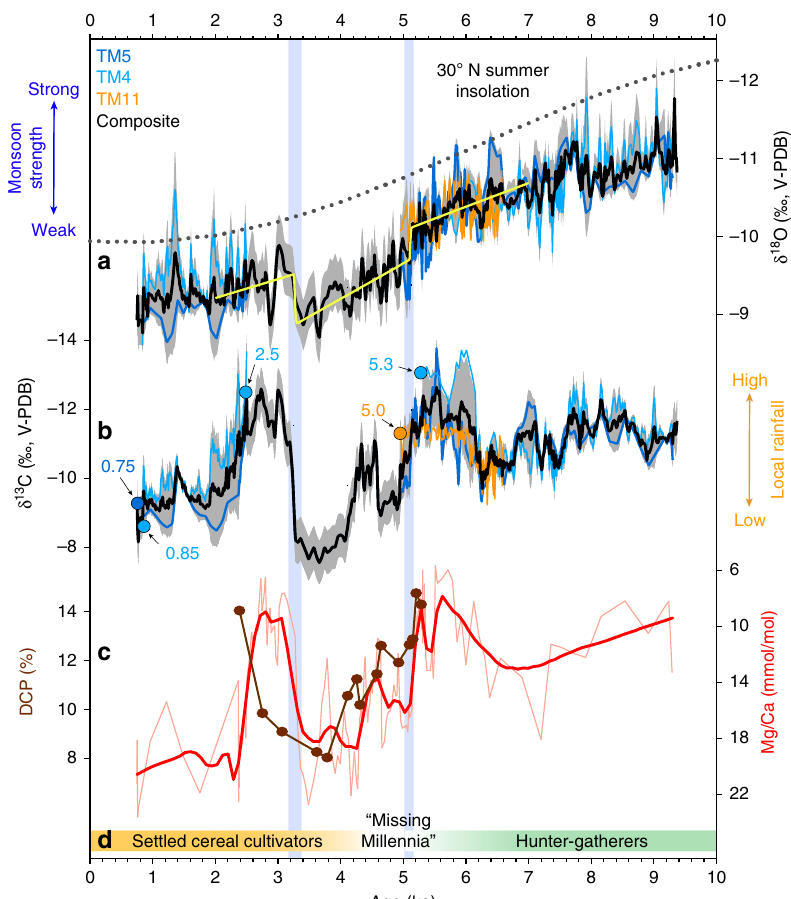
Fig. 2 The multiproxy hydroclimate record from northern Laos and cultural shifts in mainland Southeast Asia for the Holocene. a δ 18 O and b δ 13 C for stalagmites TM4 (cyan), TM5 (blue), and TM11 (orange), where values are expressed in per mill ( ‰ ) relative to Vienna Peedee Belemnite (V-PDB). Black line represents the composite record constructed by averaging data for the periods of overlap of each stalagmite record. Each record was interpolated to a common 10-year interval prior to averaging. Gray shading indicates the standard deviation for periods of overlap. For sections of the record with no overlap, the average standard deviation for overlapping periods was used. Yellow curve in panel a shows changepoints calculated using a Bayesian change-point algorithm that employs a probabilistic least-squares method to identify signi fi cant regime shifts 39 . Color-coded circles indicate times when the various speleothems stopped and started growing. Prior to averaging, the δ 18 O curve of TM11 was offset by − 0.6 ‰ . c Mg/Ca and 14 C-inferred dead carbon proportion (DCP) for stalagmite TM5. d Approximate timing of lifestyle changes in mainland Southeast Asia during the Holocene 14